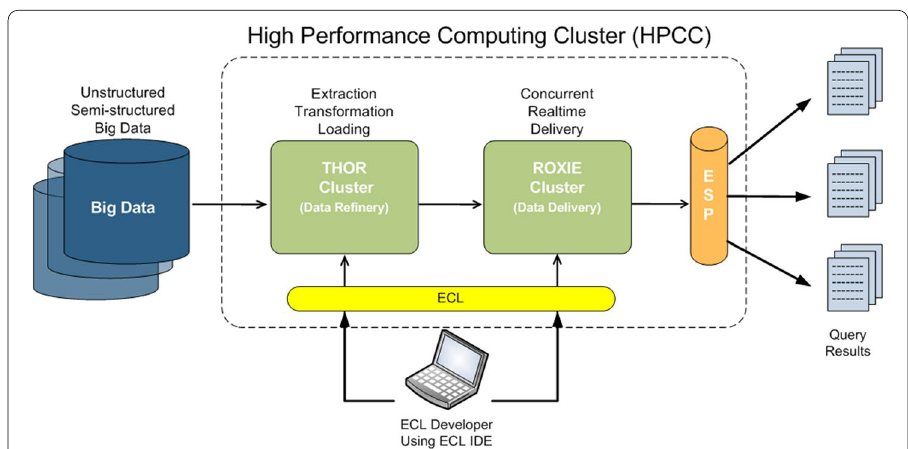
Fig. 4 Architecture of the Open Source HPCC